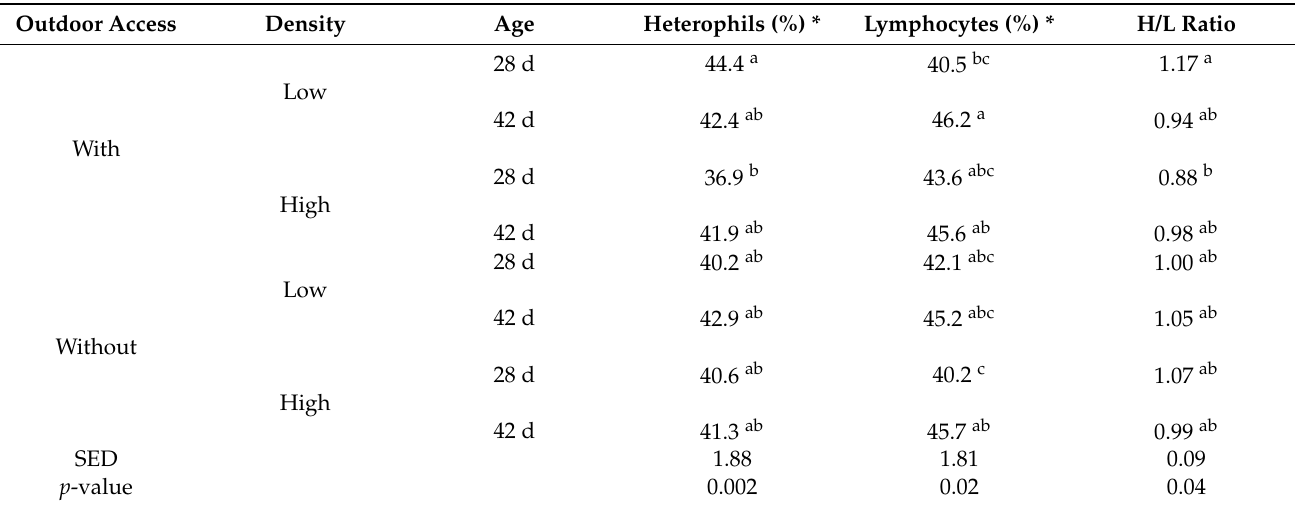
Table 8. Effects of the interaction between season, stocking density, and age on the heterophils, lymphocytes, and H/L ratio of Cobb500 broilers 1 .